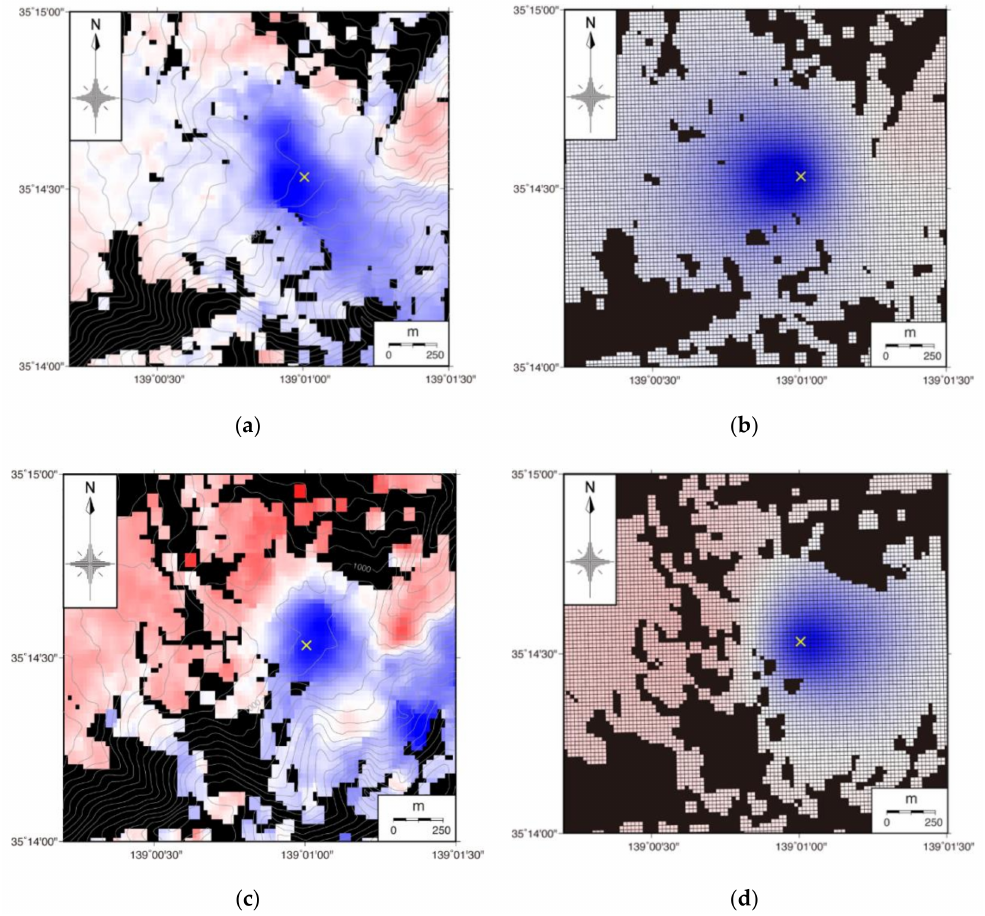
Figure 10. Results of the inversion analysis for estimating the point pressure source beneath the ground surface to the west of Owakudani: ( a ) observed velocity in the ascending orbit; ( b ) simulated velocity in the ascending orbit; ( c ) observed velocity in the descending orbit; ( d ) simulated velocity in the descending orbit. Contour lines in ( a , c ), in which intervals are 25 m, were extracted from 10 m mesh height data released by the GSI. The yellow “x” marks the location of the point pressure source, the parameters of which are shown in Table 2. Estimated o ff sets for the ascending and descending orbits are + 0.15 and + 2.43 mm / year, respectively. The color scales used for the velocity are the same as those in Figures 5 and